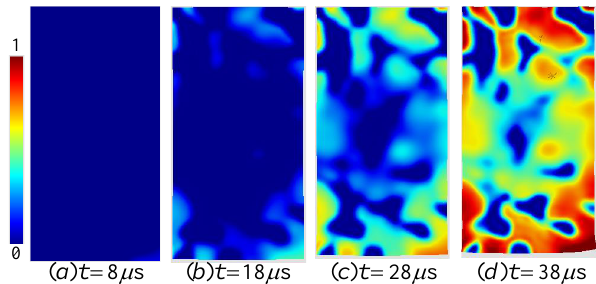
Figure 16. The evolution of damage field for the high amplitude load and cohesion realization with l c = 20 mm at times: ( a ) 10 µ s, ( b ) 20 µ s, ( c ) 30 µ s, and ( d ) 40 µ s. The results are shown on the deformed mesh with a magnification factor of 100.